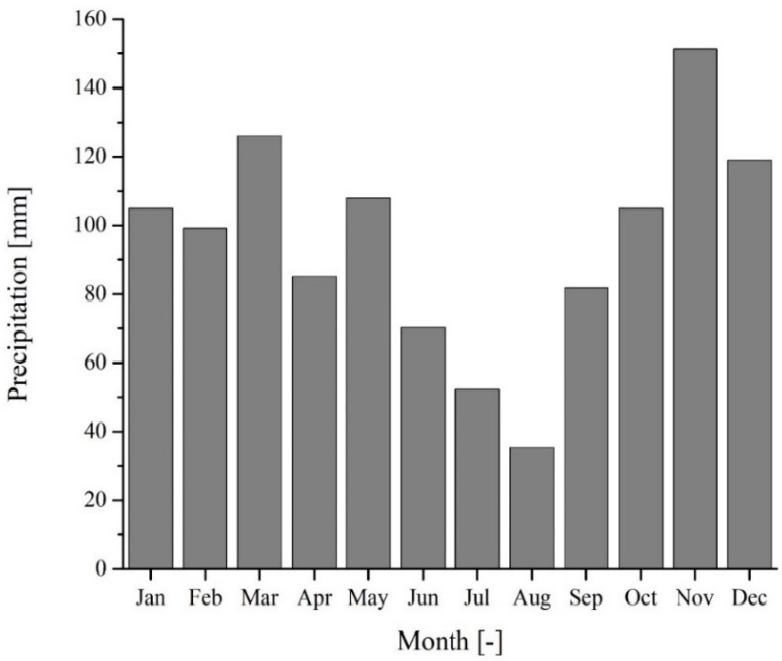
Figure 2. Observed precipitation data in Rieti province from 2008 to 2018.